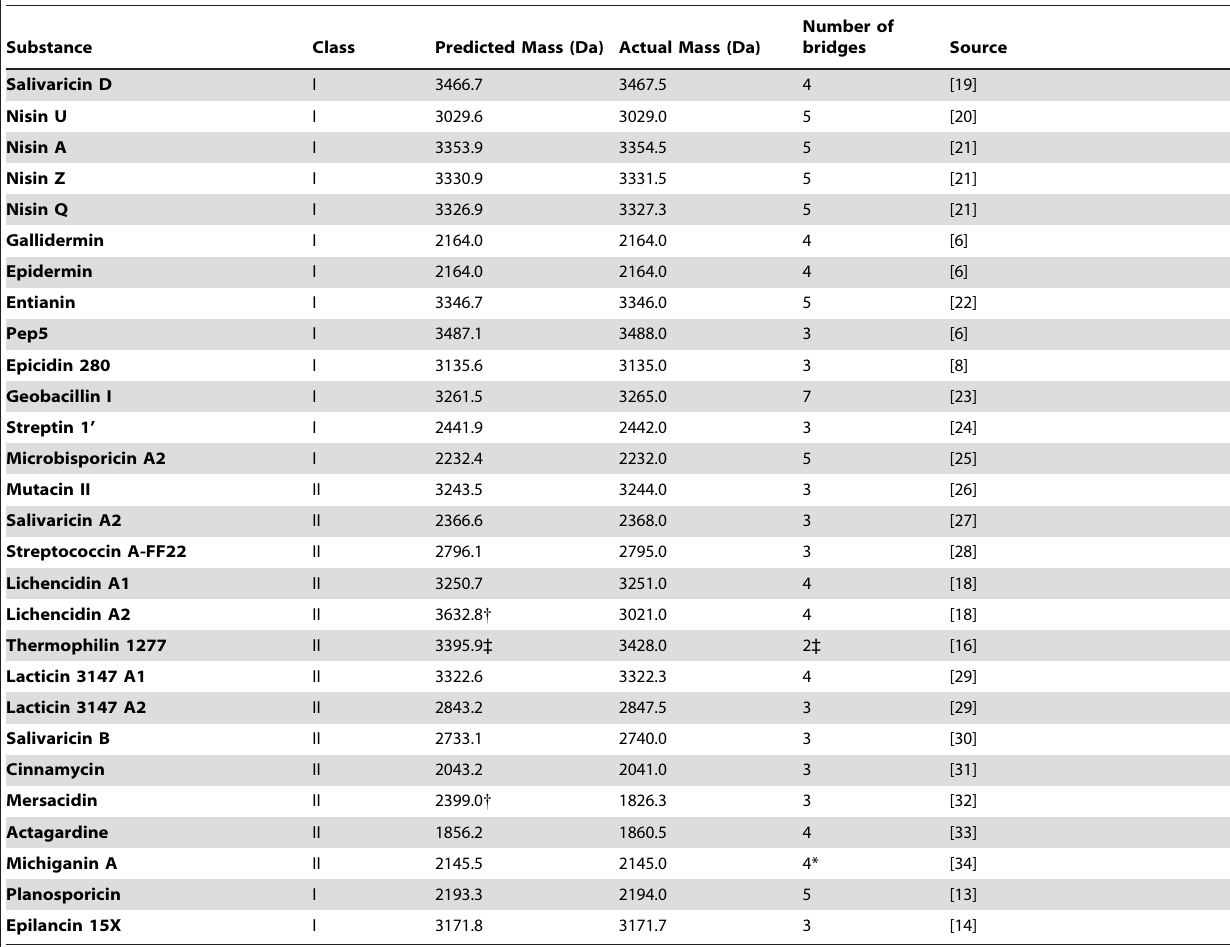
Table 5. Benchmark